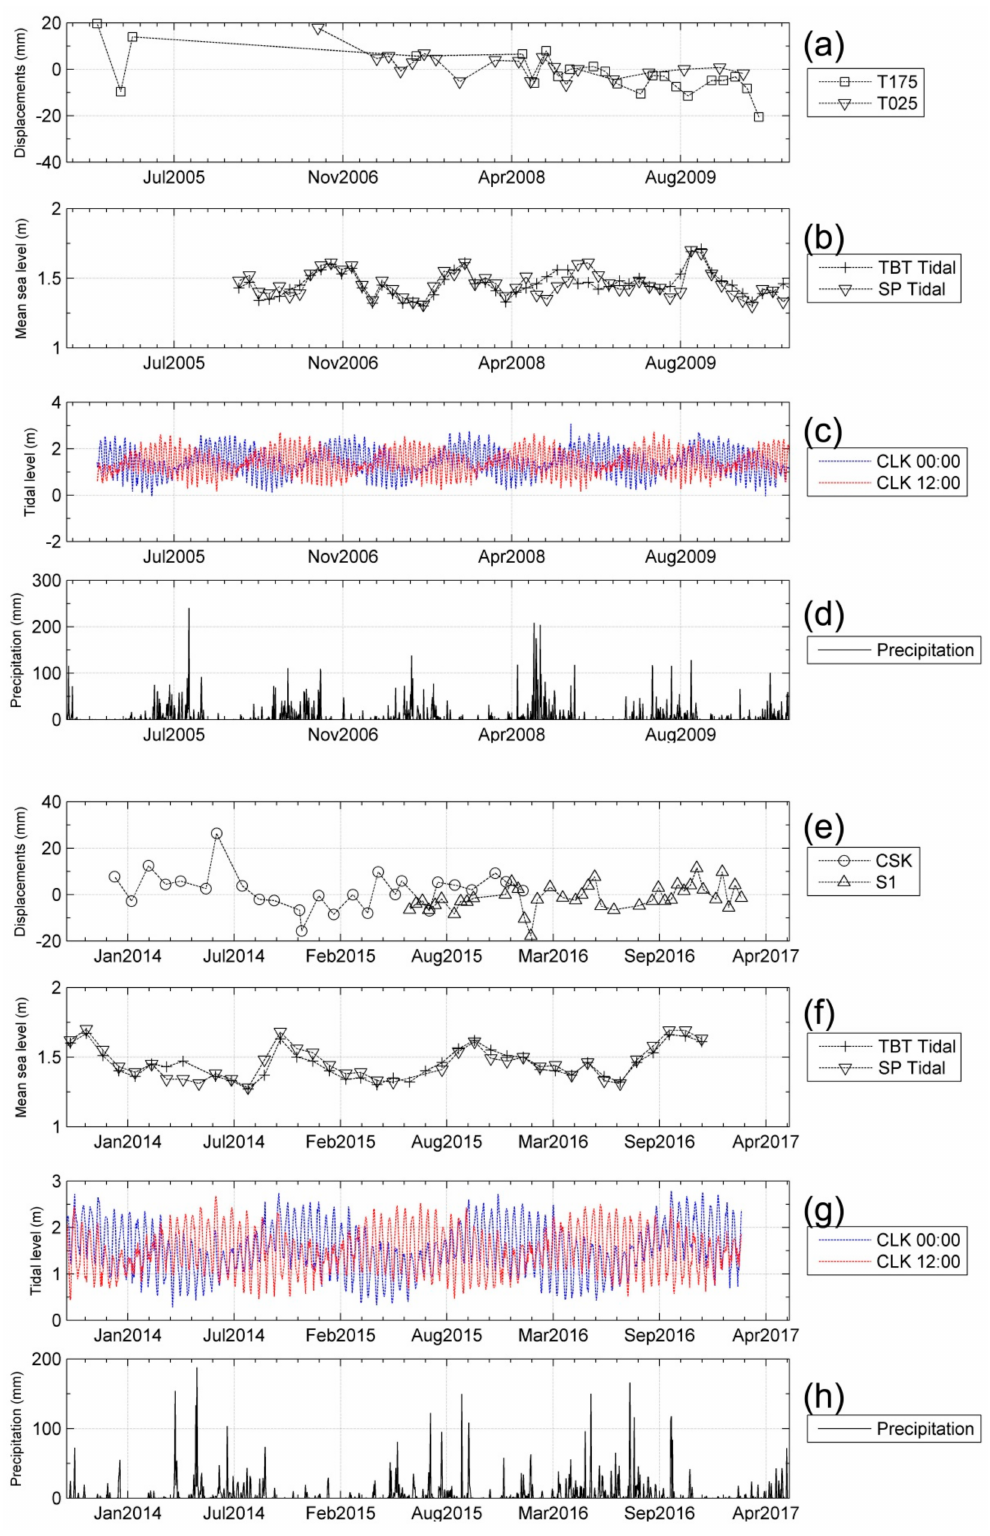
Figure 16. ( a ) Envisat T175 and T025 time series at Point P2 (Figure 5b); ( b ) Monthly mean sea levels (MSL) at Tsim Bei Tsui (TBT) and Shek Pik (SP) tidal stations managed by Hong Kong Observatory [57]; ( c ) Daily tidal level at 00:00 and 12:00 (local time in Hong Kong) at Chek Lap Kok (CLK) tidal station managed by Hong Kong International Airport. The water levels refer to the Hong Kong Principle Datum (HKPD), which is approximately 1.23 m below mean sea level between 1965 and 1983 [58]; ( d ) Daily precipitation recorded by Shenzhen National Metrological Station [51]; ( e – h ) Are the same for CSK and S1 time series at